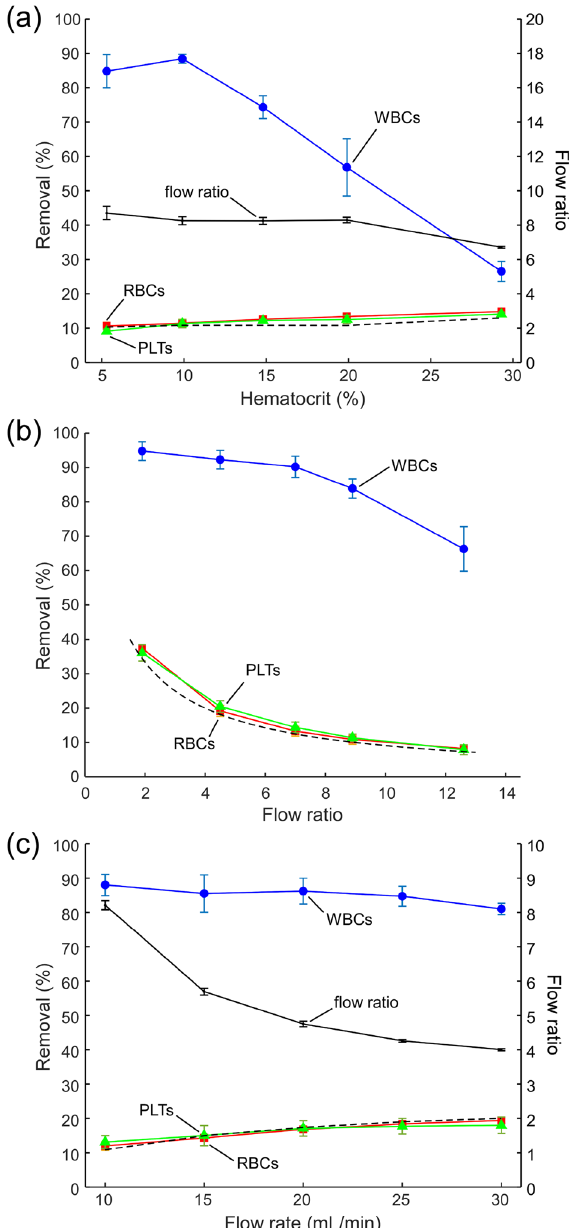
Figure 3. Performance of the CIF device in the flow-through regime. Dependence of cell removal on ( a ) sample HCT (10 mL/min flow rate, n = 3), ( b ) device flow ratio (10% HCT, 10 mL/min flow rate, n = 5), and ( c ) flow rate (10% HCT, n = 3). In panels ( a ) and ( c ), the flow ratio was set at 8.70 ± 0.39 and 8.21 ± 0.13 respectively, and then allowed to change depending on the parameters of the experiment. In each panel, a dashed line indicates the expected percent removal for cells that are smaller than the critical diameter of the device calculated based on the flow ratio measured in each experiment. Values shown are mean ± standard